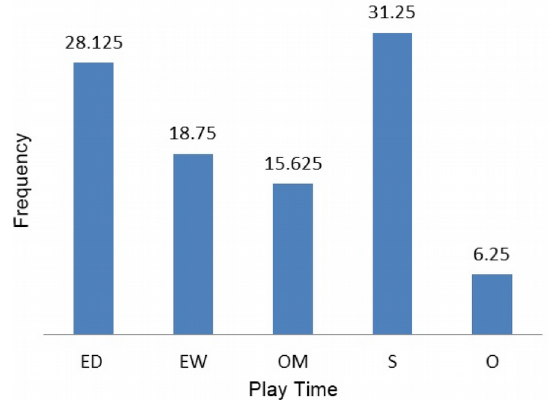
Figure 2. The frequency of students playing the Chebo Collect game. ED: Every